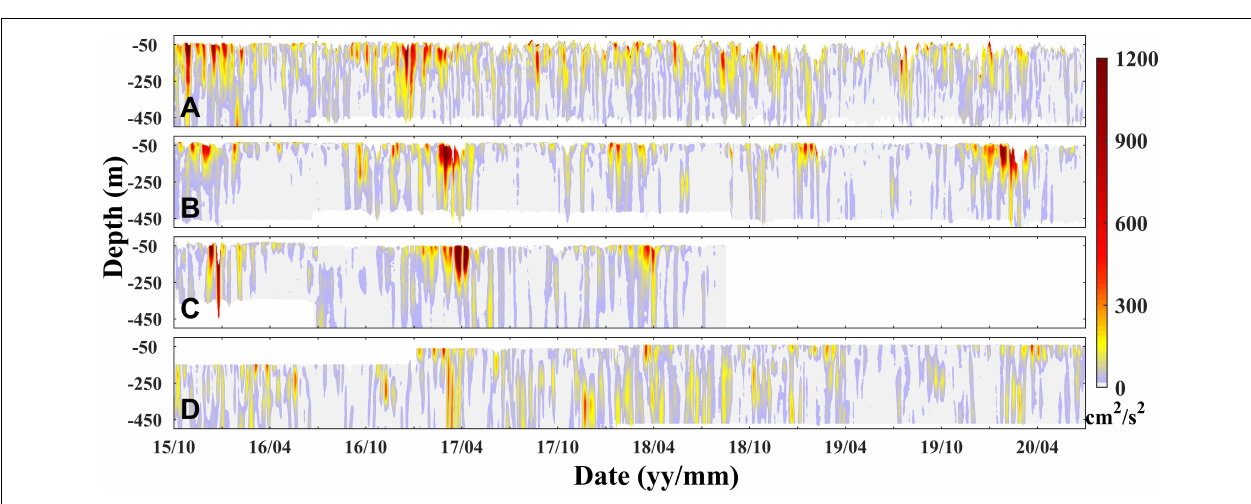
FIGURE 5 | Time series of 10–65-day eddy kinetic energy (cm 2 /s 2 ). Station (A) LS01, (B) DS01, (C) DS02, and (D)